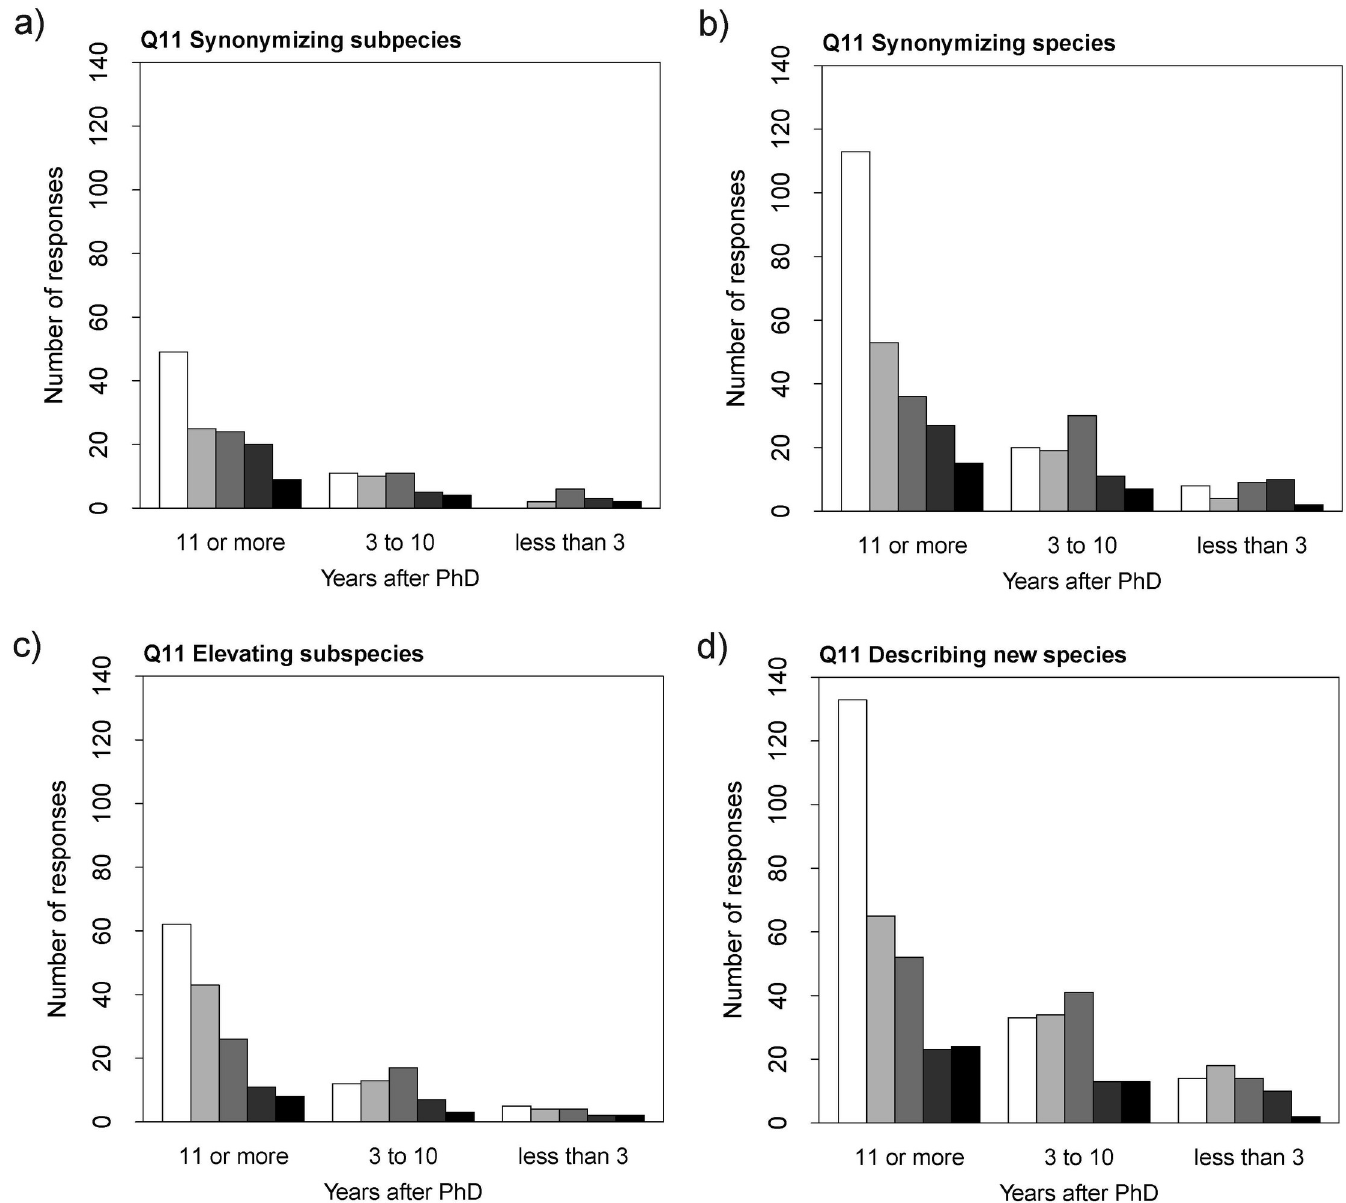
Fig 1. Responses to Q11. Number of responses of Q11 relative to years after PhD for different types of nomenclatural acts. Colours represent the scores from 1 to 5 increasing from lightest (1 = easiest) to darkest (5 = hardest).